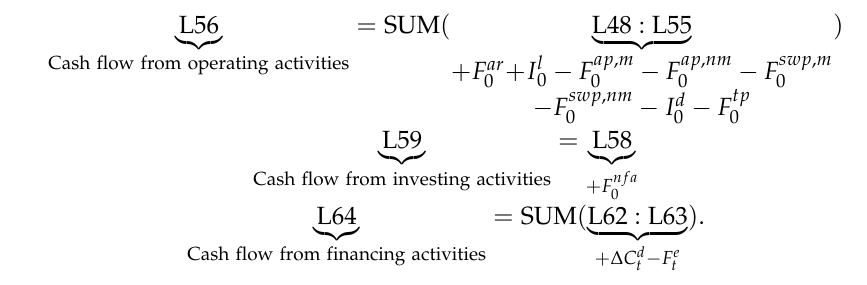
Figure 55. Cell L62 contains the formula for calculating the variation ∆𝐶 (cid:2868)(cid:3031) as the difference between values in row 61 (“ConventionalFinStat” sheet).